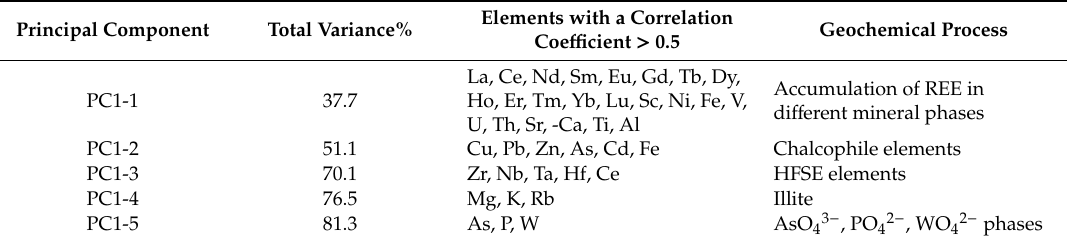
Table 2. Results of the first principal component analysis